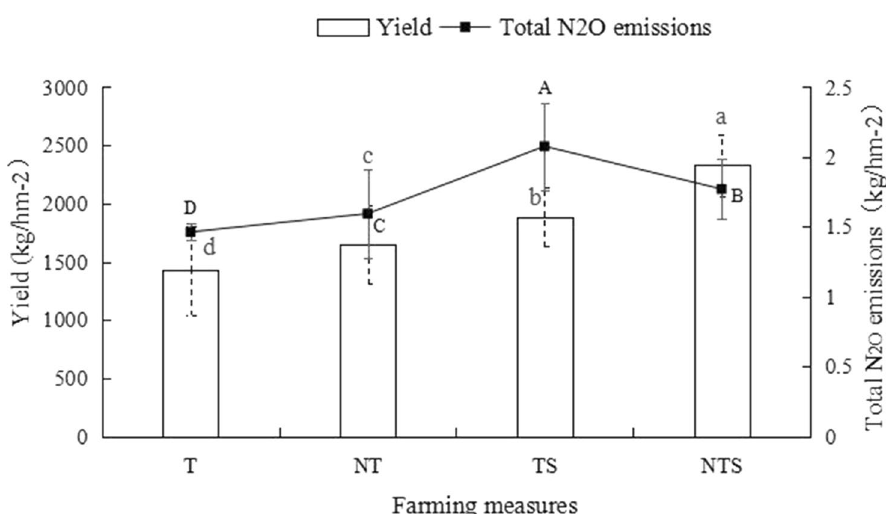
Figure 5. Spring wheat yield and total N 2 O emissions under different tillage measures. Different capital letters indicate that there are significant differences in total N 2 O emissions under different treatments; Different lowercase letters indicate that there are significant differences in yield under different